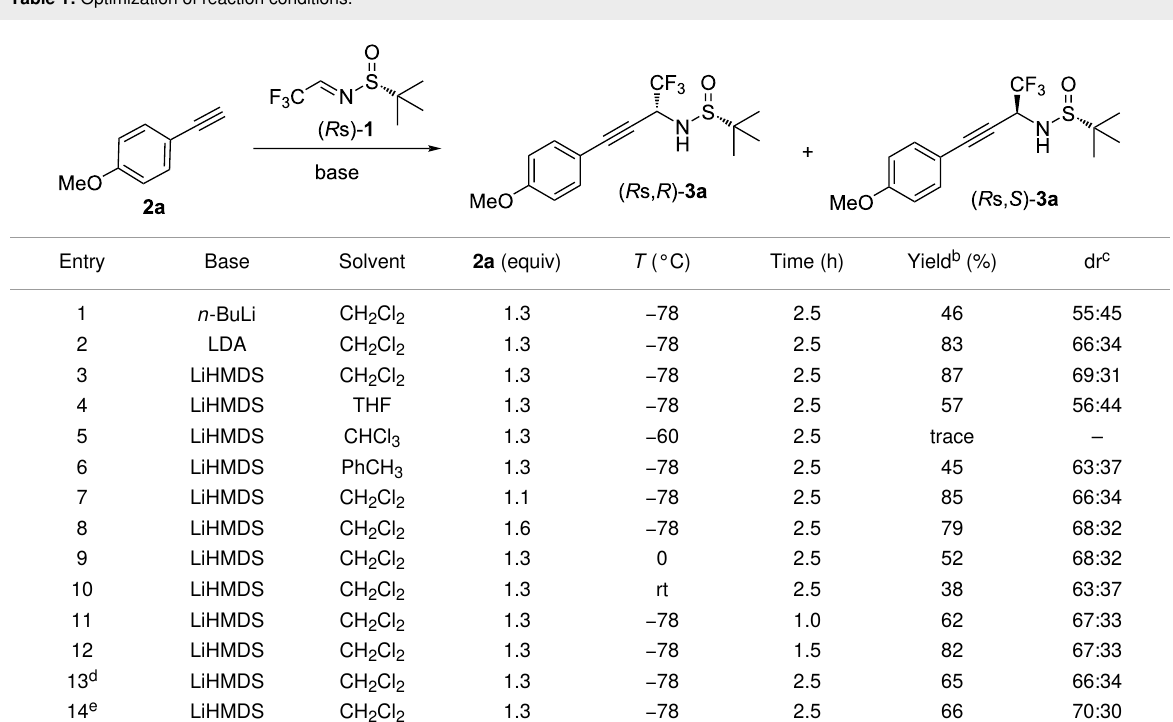
Table 1: Optimization of reaction conditions. a